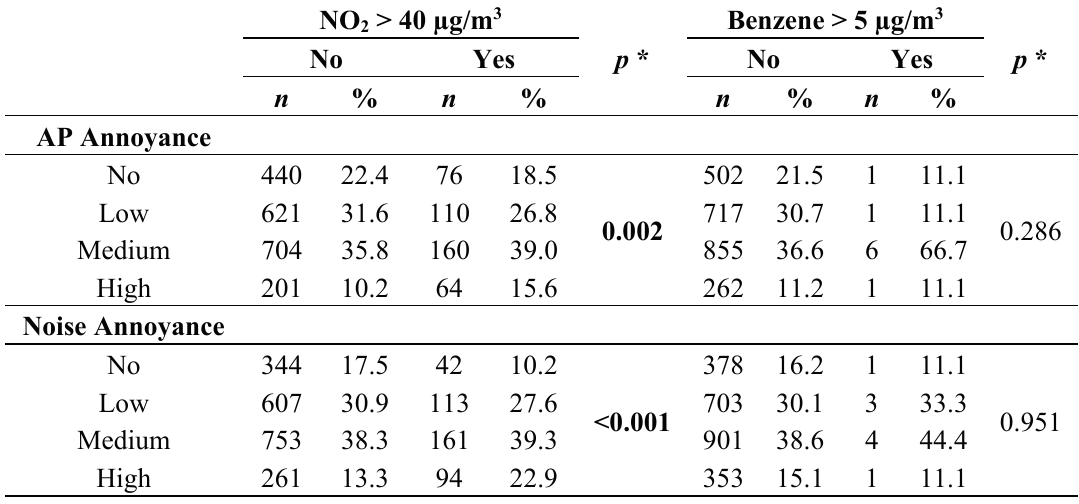
Table 3. Distribution of annoyance levels by compliance of air pollution